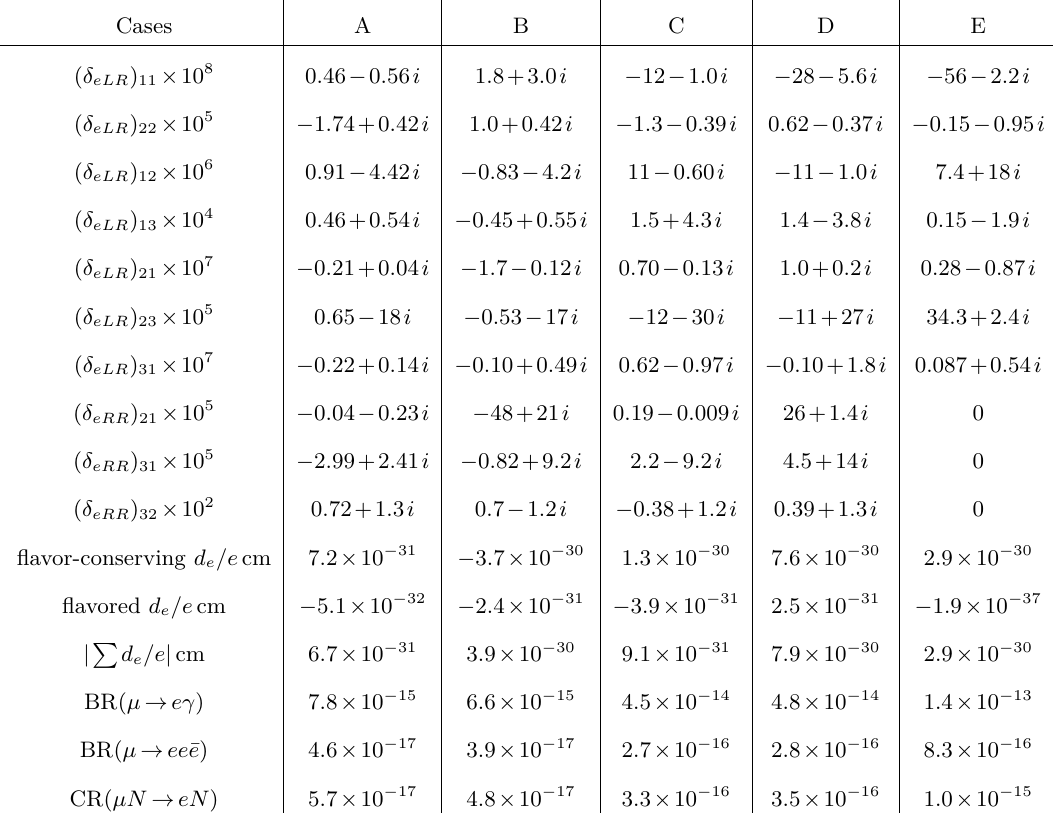
= 6 TeV, m 0 = 10 TeV and 1 / 2